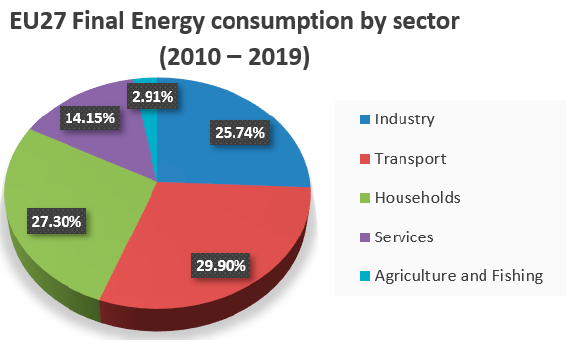
Figure 1. Final Energy consumption by sector in 27 Member States of the European Union (average from final energy consumption registered in 2010–2019). Adapted from [1].